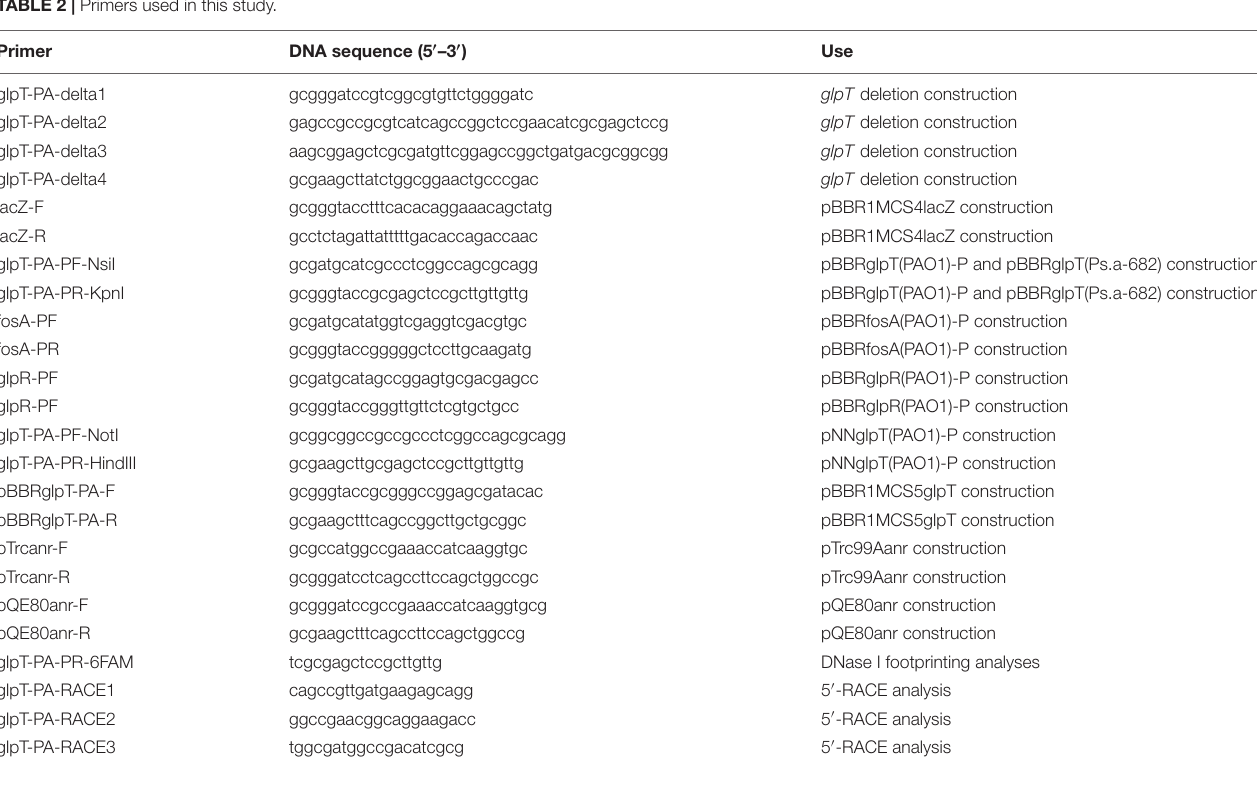
TABLE 2 | Primers used in this